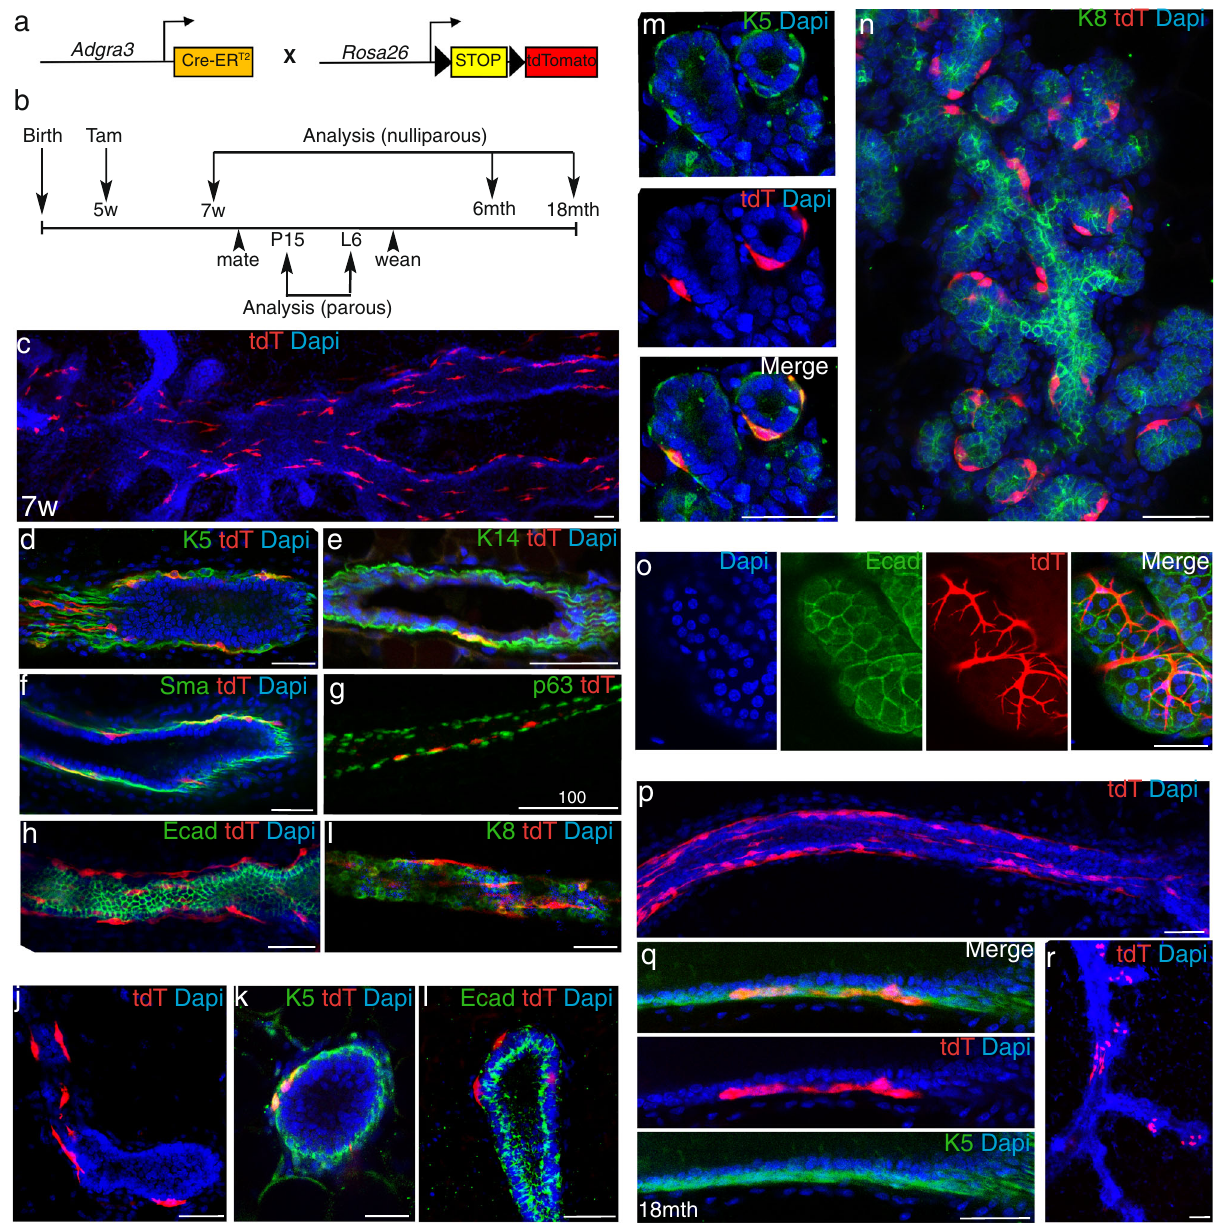
Fig. 3 Pubertal Gpr125 + cells are long-lived unipotent basal progenitors. a Genetic strategy used to target tdTomato expression to Gpr125/Adgra3 - expressing cells and their progeny. b Schematic illustrating strategy to trace the lineage of cells that express Gpr125 during early puberty by delivering Tamoxifen (Tam) to (5w) nulliparous mice and harvesting glands during late puberty (7w), pregnancy (P15); lactation (L6), and in aged and multiparous mice. c Representative 3D-imaging of mammary gland nipple-proximal region of Adgra3-CreER T2 ;tdT mice analyzed 2 weeks after labeling. d – g tdT + cells with immunolocalization (green) of basal markers K5, K14, SMA, and p63, and exclusion of luminal markers Ecad, K8 ( h , i ). j tdT + cells in the cap cell layer of TEB and subtending duct with immunolocalization of basal K5 ( k ) and exclusion of luminal Ecad ( l ). m p15 Immature alveoli show basally located tdT + cells that express K5, but lack K8 expression ( n ). o tdT + cells form characteristic basket-like morphology of mature myoepithelial cells enmeshing an Ecad + alveolus in the lactating mammary gland. p – r Extensive strips of tdT + cells remain along the outer basal layer of ducts in aged mice ( p , q ) and after multiple pregnancies ( r ). Scale bar = 50 µ m. tdT = red, tdT + cells; DAPI = blue nuclear staining. Two glands from each of the fi ve mice were wildtype cells and found Adgra3 mRNA is highly upregulated in by X-gal staining. Gpr125- β -gal appeared focally where side- Bsl2 and BslG populations beginning ~p4.5 and peaking ~p14 branches emerge from ducts and concentrated at branch tips (Fig. 4a – c) 44 . Adgra3 appears at #23 in the list of differentially (Fig. 4d – e, g – j). X-gal staining was prominent along the basal expressed marker genes for Bsl2 and #63 for BslG population layer of permanent ducts during late pregnancy but was absent (https://crukci.shinyapps.io/brca1tumourigenesis/) 44 . from differentiating alveoli (Fig. 4f, k, l) with the exception of rare To investigate Gpr125 protein expression during early Gpr125- β -gal + cells that likely represent the branch tip of each pregnancy (p12-13.5) we again detected Gpr125- β -gal expression alveolar cluster (Fig. 4k arrowheads).